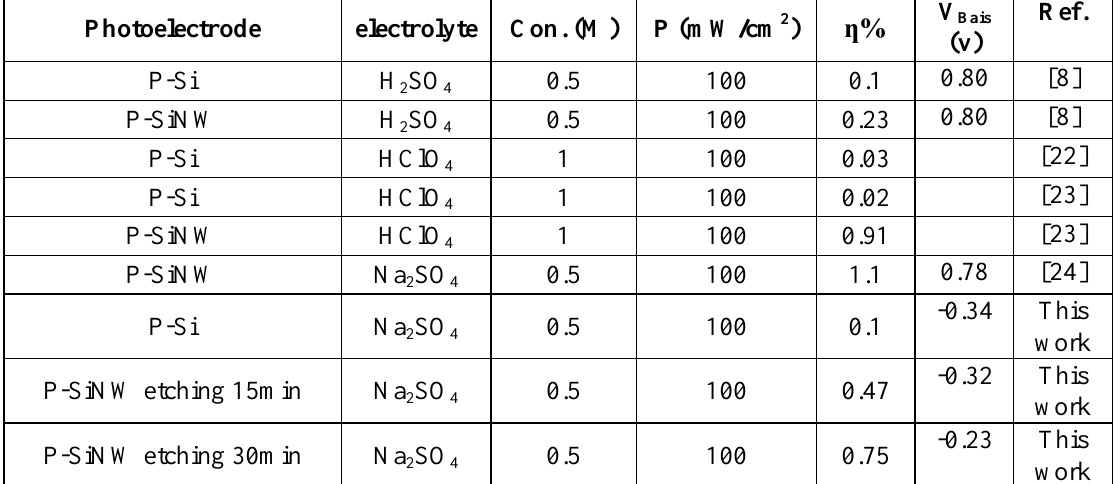
Table 1: Photoconversion efficiency(ƞ) of prepared SiNWs using different durations compared with previous works